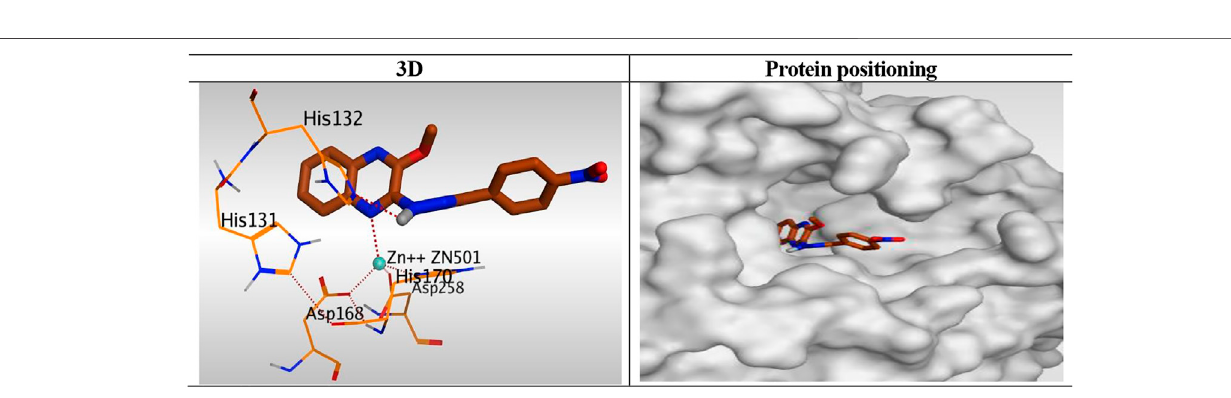
FIGURE 9 | 3D representation and positioning for the docked 10 h inside the tubular pocket of the HDAC